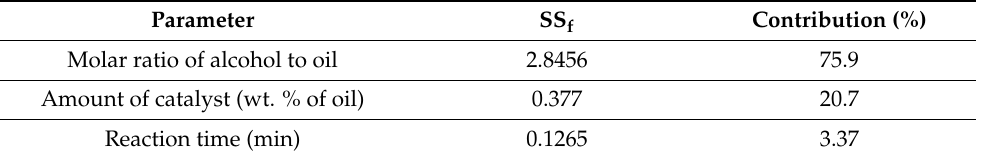
Table 7. Percentage contribution of variables selected for mean yield of TIME S .